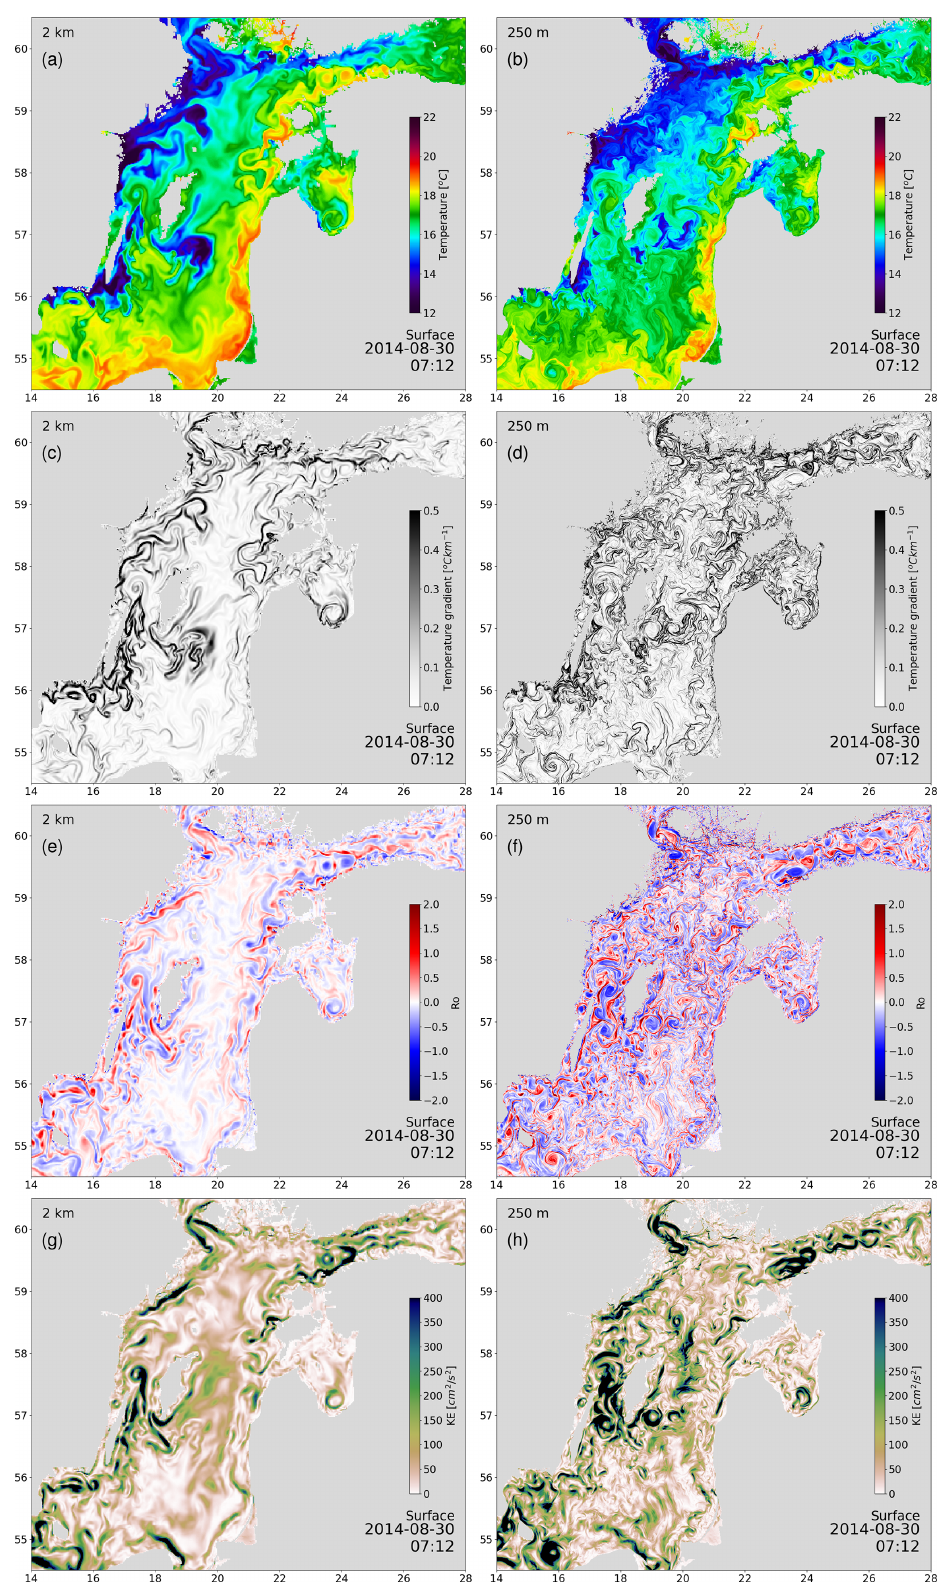
Figure 15. (a, b) Snapshot of surface layer temperature ( ◦ C). (c, d) Temperature gradient ( ◦ Ckm − 1 ). (e, f) Rossby number and (g, h) kinetic energy (cm − 2 s − 2 ), as obtained from the low-resolution (1n.m., left) and high-resolution (250m, right) simulation for the Baltic